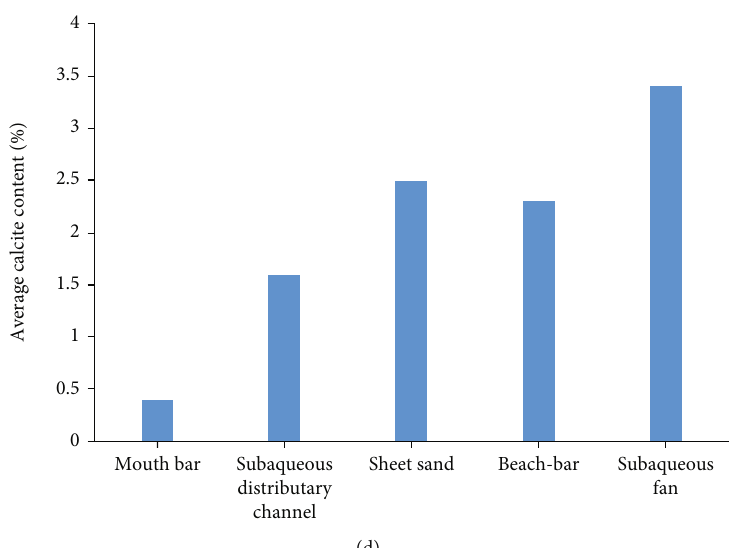
Figure 13: Histograms show the kaolinite (a), average muddy matrix cement (b), average cement content (c), and average calcite content (d) in the sandstones of di ff erent depositional